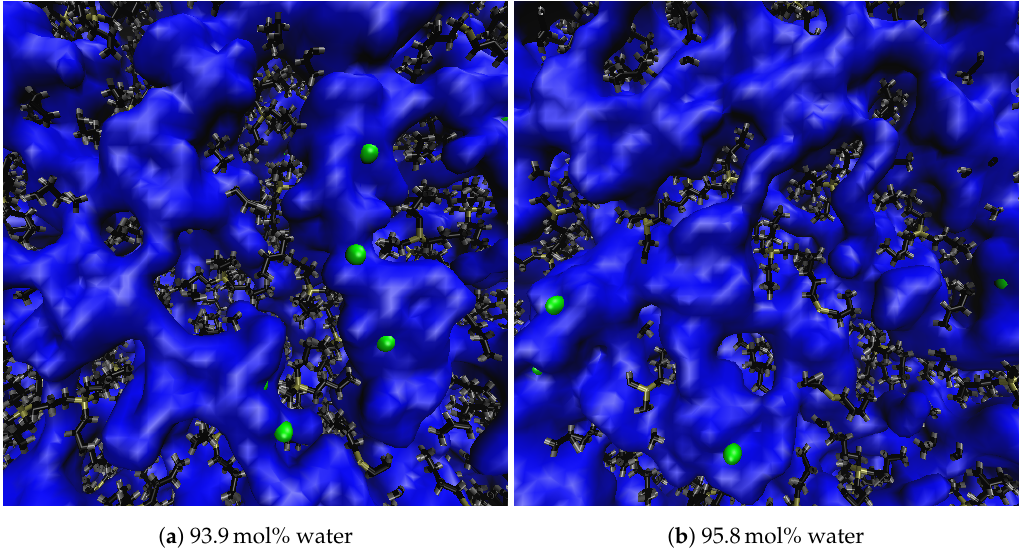
Figure A4. Water veins and channeling in TBPCl at 360K (Part 2 of 2) [27,28]. The Figures represent the changing water structure with increasing water concentration: ( a ) 93.9mol% water; ( b ) 95.8mol% water. The blue-colored water is represented using an isosurface drawing method (called quicksurf in VMD [13]), which uses a volumetric Gaussian density map of the water to produce the observable surface. The TBP molecule is represented using dynamic bonds in VMD [13]. TBP is colored tan, black and gray, for the phosphorus, carbon, and hydrogen atoms, respectively. The green chloride is represented using the Van Der Walls (VDW) drawing method in VMD